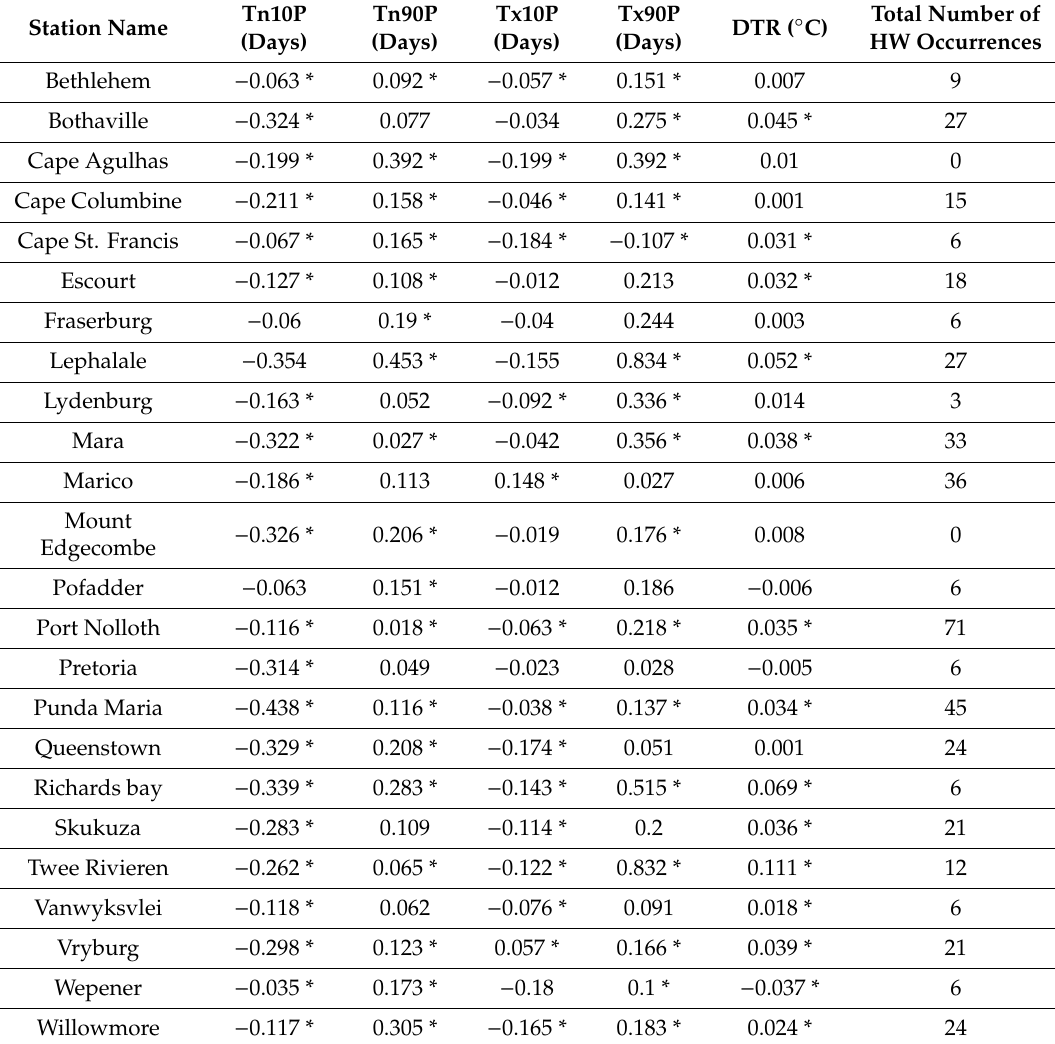
Table 3. Trend results for selected temperature indices from 1983 to 2012 (* indicates significance at the 95% level of confidence) and total number of heatwave (HW) occurrence per